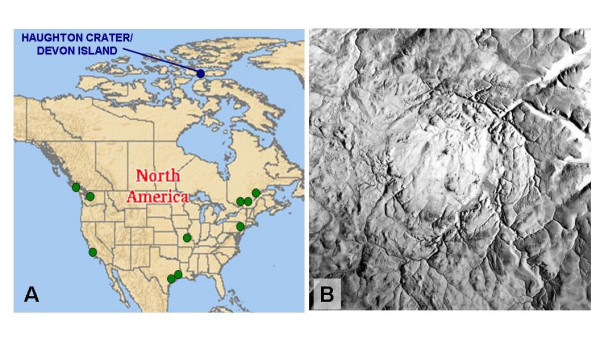
(A) Map indicating the location of the HMP research Station on Devon Island, Canadian High Arctic. The home locations of the 10 HMP study participants are also indicated (green circles). (B) Airborne synthetic aperture radar image of Haughton Crater acquired in 1998 by the Intera STAR X-band radar system. The width of the scene is 36 km. The crater is approximately 20 km wide. North is up. Image courtesy Geological Survey of Canada and HMP.